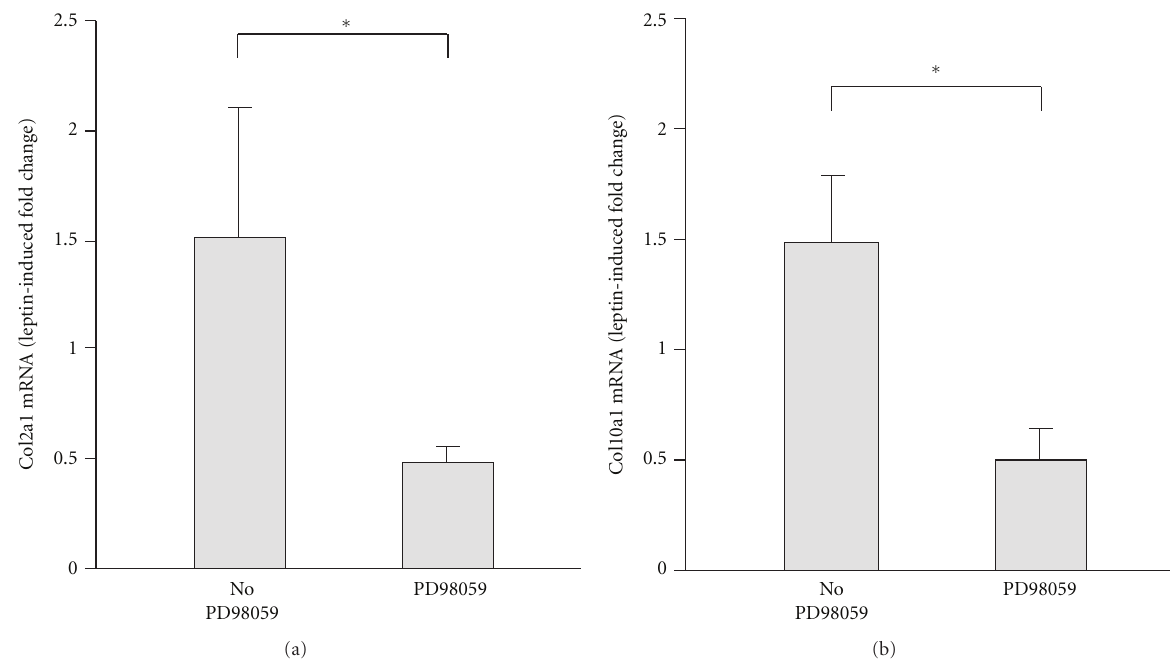
Figure 3: Leptin suppresses the PPAR γ inhibitory e ff ects on growth plate chondrocytes by activating MAPK/ERK signaling pathway. ((a), (b)) Gene expression of chondrogenic di ff erentiation marker Col2a1 (a) and terminal di ff erentiation marker Col10a1 (b) in chondrocytes treated with ciglitazone and leptin for 5 days in the presence and absence of PD98059. T3 was added to induce the chondrocyte terminal di ff erentiation. Data are presented as the leptin-induced fold changes in ciglitazone-treated chondrocytes, normalized to the expression in cells treated with ciglitazone alone. ∗ P < 0 . 05 versus expression changes in the chondrocytes untreated with